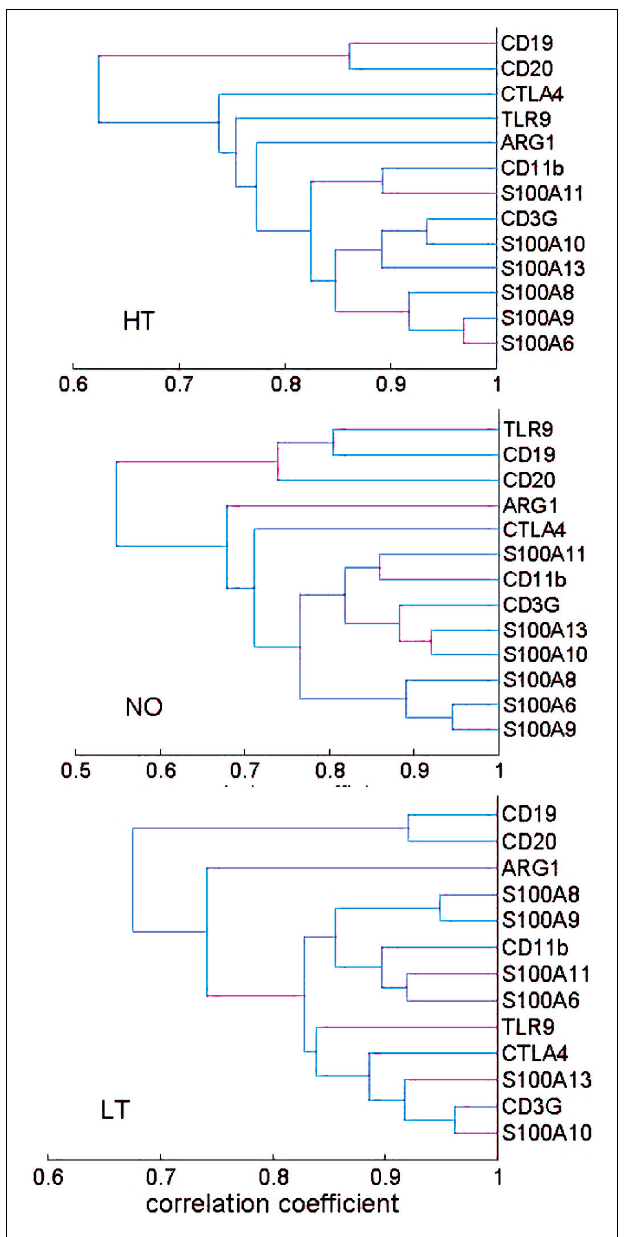
FIGURE 2 | Hierarchical clustering analysis of expression relationship among innate and adaptive immune genes. A dendrogram was presented based on correlation coefficient of gene expression levels.The HT, NO, and LT groups exhibited a similar pattern of gene expression correlation. Most of the 13 genes appeared in two clusters: a B cell cluster and a cluster consisting of bothT cell and myeloid cell genes.The sample size in the AT group ( n = 19) may not be sufficient for the clustering